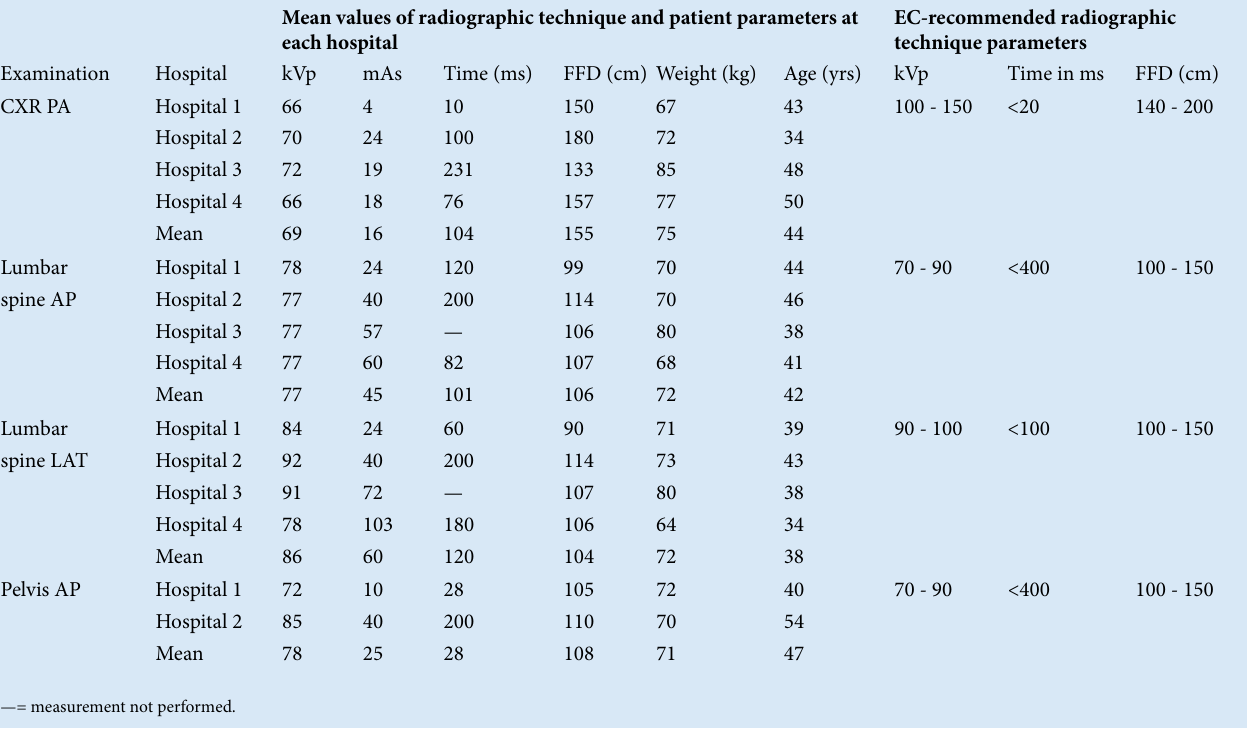
Table IV. The range of radiographic exposure factors, patient parameters, and EC-recommended radiographic technique Mean values of radiographic technique and patient parameters